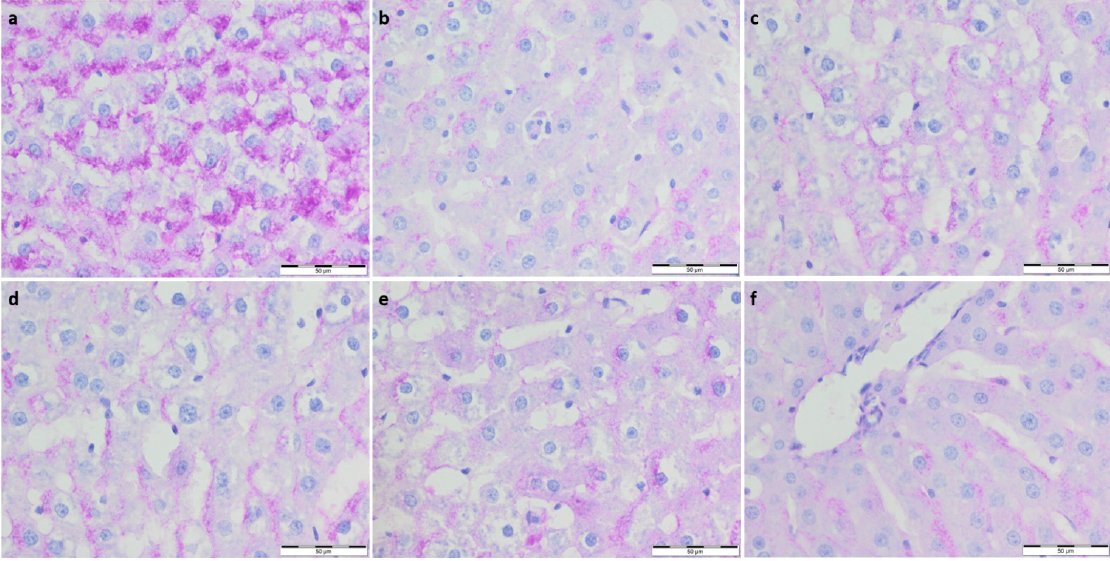
Figure 1. ( a ) Con-Sed, ( b ) Con-Run, ( c ) WP-Sed, ( d ) BP-Sed, ( e ) WP-Run and ( f ) BP-Run; BP-Run; Periodic acid Schiff; Glycogen was visualized using the periodic acid-Schiff reagent; Statistical decrease in glycogen deposition is visible in all experimental group compared to the Con-Sed group.